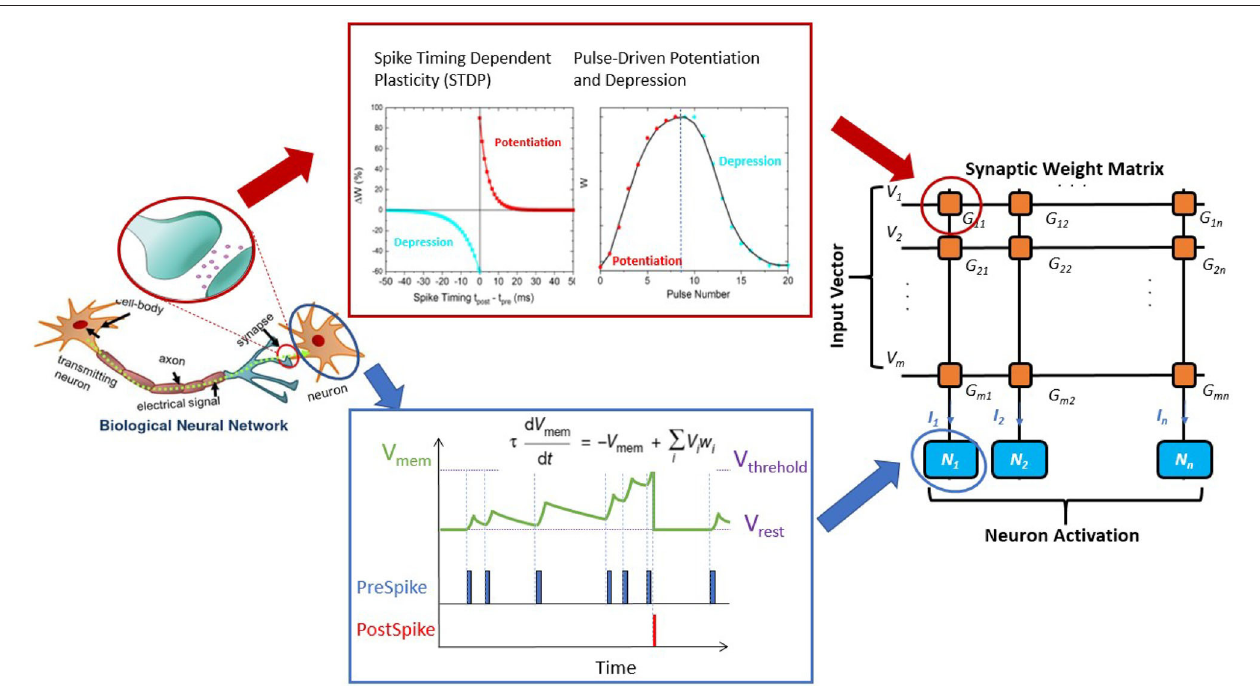
FIGURE 1 | Concept of a biological neural network and its hardware implementation in crossbar arrays. Left panel illustrates that two biological neurons are interconnected by a synapse. The strength of the synaptic connections (synaptic weights) can be modified depending on the relationship between the two neurons. A crossbar array implementing artificial neural networks containing neurons connected by synaptic devices is shown in the right panel. The center panel describes synapse (top) and neuron (bottom) models. The activation of a neuron is controlled by its membrane potential, and its dynamics can be described of a leaky integrate-fire (LIF) neuron model. An accurate description of the membrane potential desires devices that can represent analog state values. Neurons are interconnected by synapses, which can be put into crossbar devices with variable conductance states. Spiking timing dependence plasticity (STDP) and pulse driven potentiation/depression of a synapse is shown to illustrate one bio-plausible learning mechanism based on synaptic plasticity.